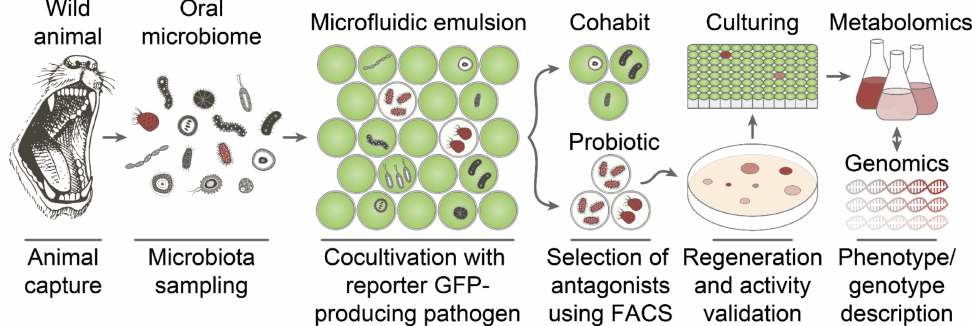
Figure 1. Principal scheme of ultrahigh-throughput selection of probiotics. The wild animal is captured and the oral microbiome is isolated by non-invasive probing. Single cells of the microbiome community are coencapsulated with a reporter GFP-producing pathogen in biocompatible droplets of a microfluidic double water-in-oil-in-water emulsion. Cocultivation of a bacterial community with reporter bacteria in droplets results in two distinct populations containing bacterial cohabits and probiotic bacteria, thus mediating pathogen killing. The latter is selected by a low level of GFP fluorescence using FACS. The selected droplets are plated on agar to regenerate culturable probiotic strains. Regenerated clones are validated by coculturing assays and analyzed by activity-guided metabolomics and genomics. Detailed phenotype and genotype descriptions enable us to identify antibiotics and their biosynthetic gene